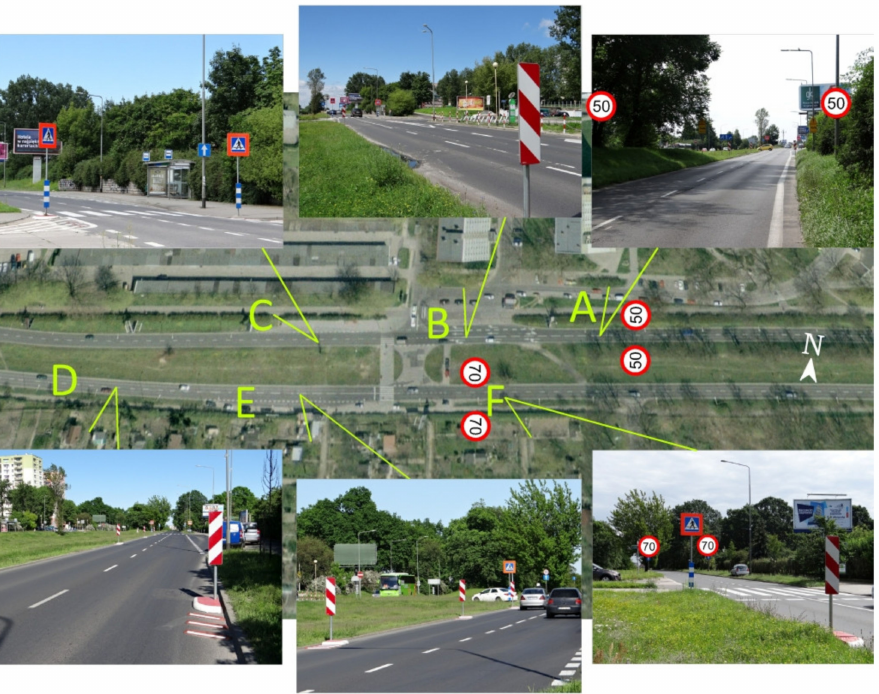
Figure 5. Location of the test sections on both carriageways under analysis: A, B and C—test sections on the westbound carriageway preceded by a ca. 600 m long straight section of the road; D, E and F—test section on the eastbound carriageway preceded by a ca. 130 m long straight section starting from the signalised intersection to the